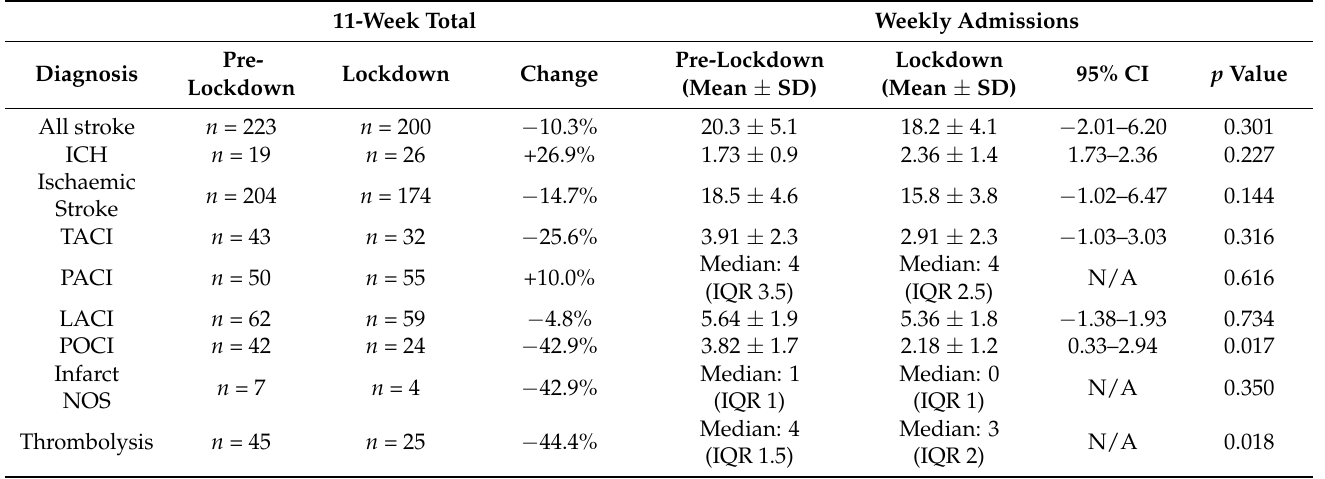
Table 1. Stroke Admissions in the Pre-lockdown and Lockdown Cohorts. Stroke admissions data in the lockdown and pre-lockdown cohorts. There were significantly reduced weekly posterior circulation infarcts and thrombolysed stroke admissions in the lockdown cohort. p values were generated with Student’s t-test if data were normally distributed, otherwise Wilcoxon’s signed-rank test was performed; values <0.05 were deemed statistically significant. All stroke: All ischaemic and haemorrhagic strokes admitted, ICH: intracerebral haemorrhage, TACI: total anterior circulation infarct, PACI: partial anterior circulation infarct, LACI: lacunar infarct, POCI: posterior circulation infarct: NOS: not otherwise specified, SD: standard deviation, IQR: interquartile range, CI: confidence intervals, NA: not